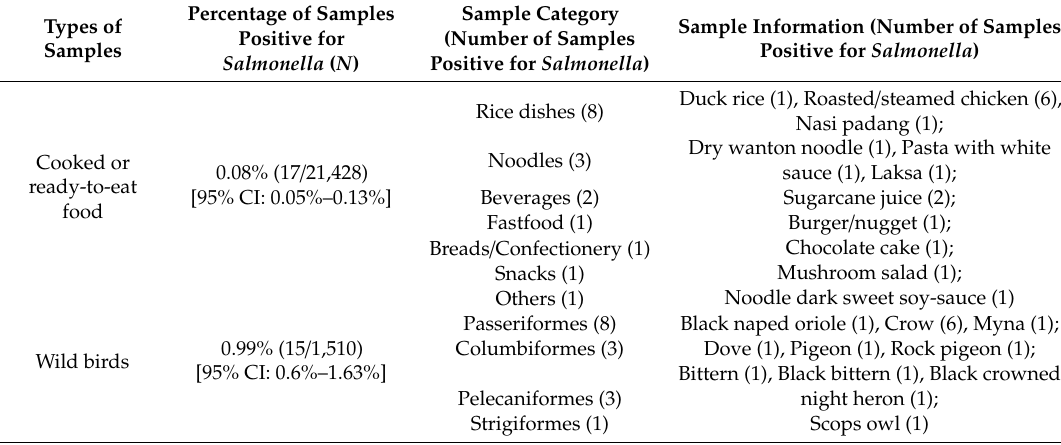
Table 1. Prevalence of Salmonella in cooked or ready-to-eat food and wild birds.